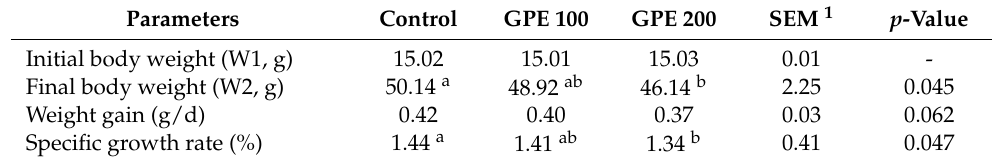
Table 2. Growth performances of European sea bass fed diets with two levels of red grape